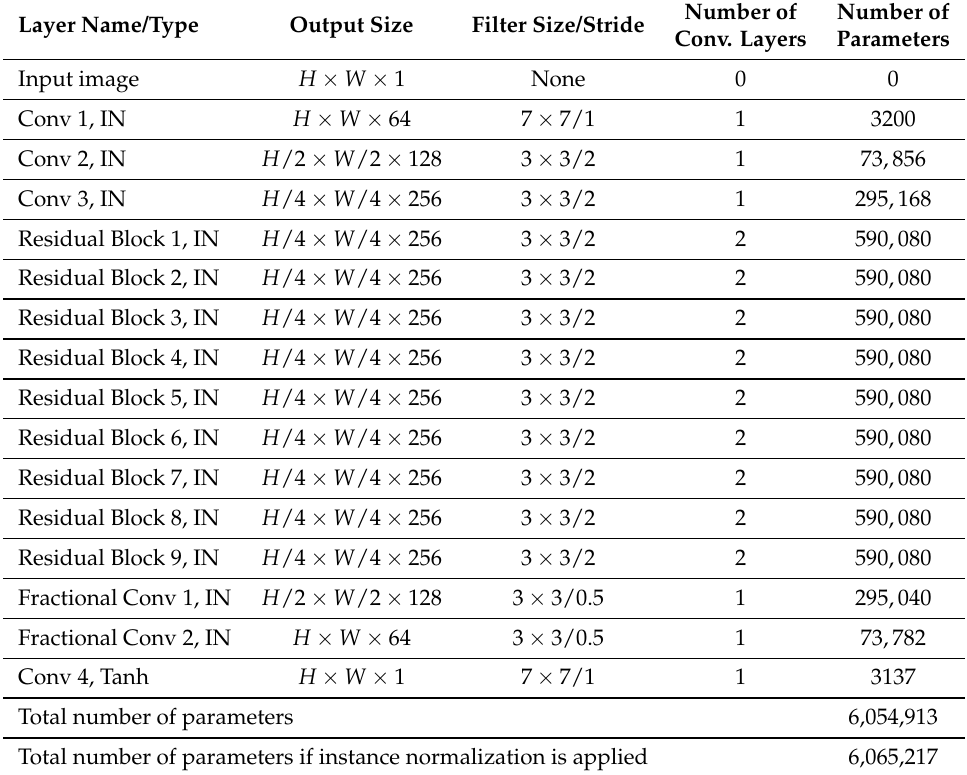
Table 4. Model architecture of the synthesis network. Layers marked with IN indicate that the convolution layer is followed by the instance normalization layer. The ReLU activation layers are